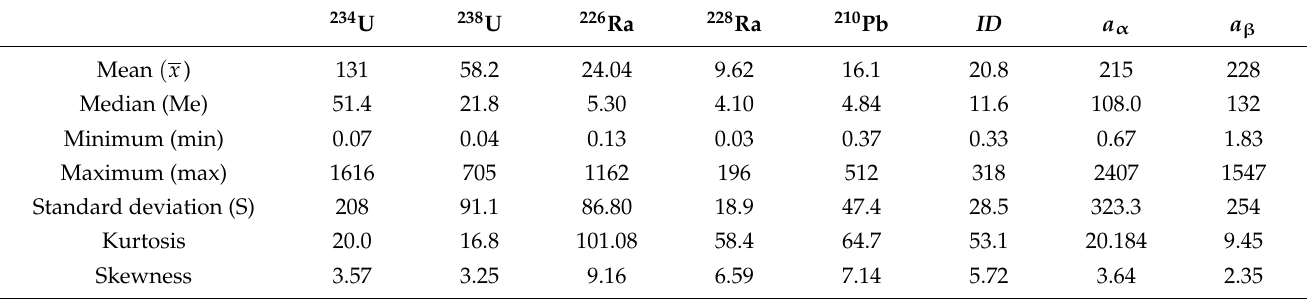
Figure 3. Geostatistical exploration corresponding to the a α analysis: ( a ) histogram; ( b ) log-transformed QQ normal plot; ( c ) trend analysis; ( d ) semivariogram. Table 2. Statistical analysis of activity concentration of the main natural radionuclides and radioactiv- ity parameters in the interconnected groundwaters of Castilla y Le ó